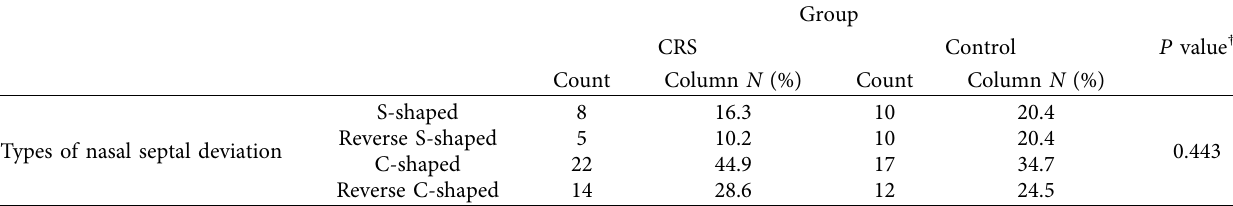
Table 2: Frequency of different types of nasal septal deviation in the coronal and axial planes in the CRS and control